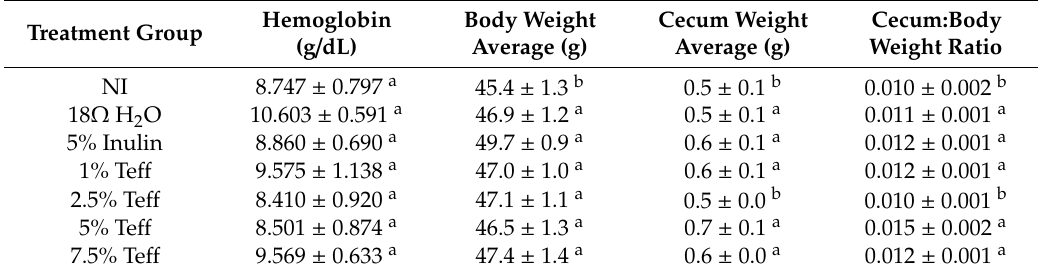
Table 5. Hemoglobin, body weight, cecum weight, and cecum:body weight ratio in all groups 1 .